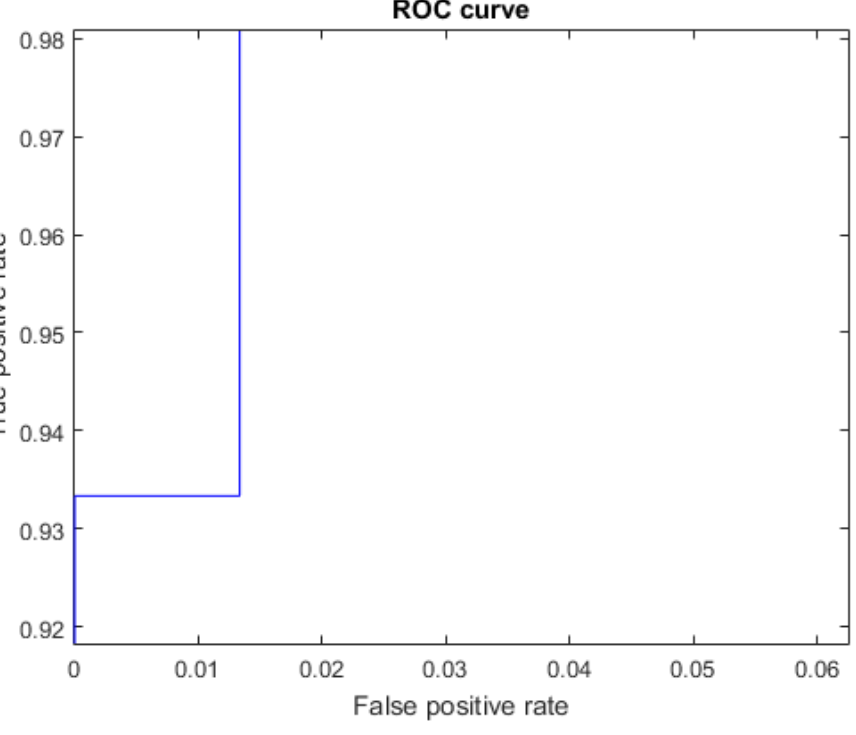
Figure 13. ROC curve for the letter B using Cartesian features, AUC = 0.9991.